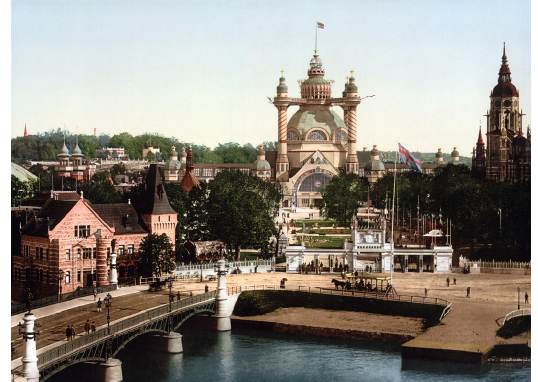
Figure 2. Allmänna konst- och industriutställningen 1897 ( The General Art and Industry Exhibition 1897 ) in Stockholm. In the centre of the photo is the Great Exhibition Hall by Ferdinand Boberg (1860–1946) and Fredrik Lilljekvist (1863–1932). Hand-coloured photochrome, Detroit Publishing Co., United States Library of Congress, Public Domain.